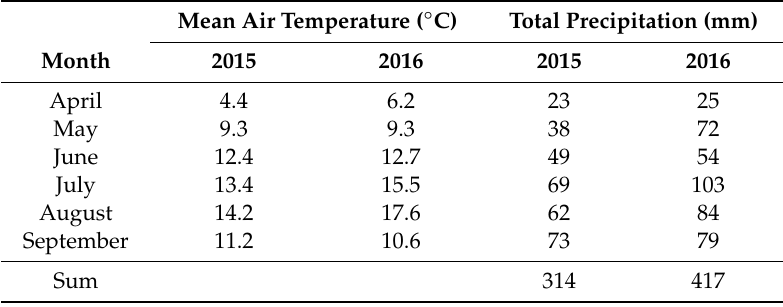
Table 1. Monthly mean air temperature and total precipitation during the 2015 and 2016 cropping seasons at the Xiahe experimental station, Gansu,